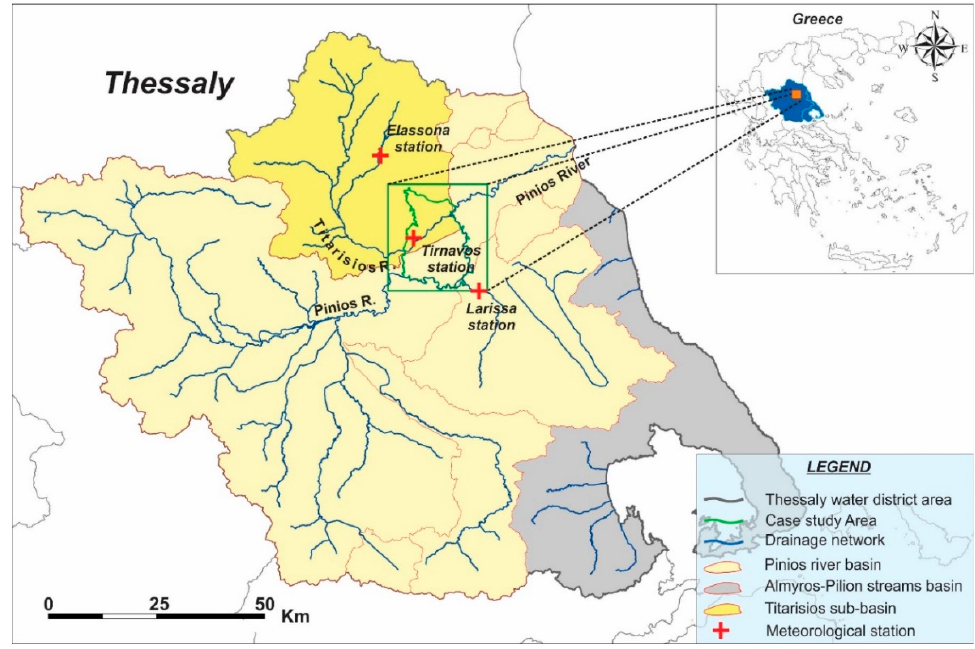
Figure 1. Location map of the case study area where the RIVA method has been applied.